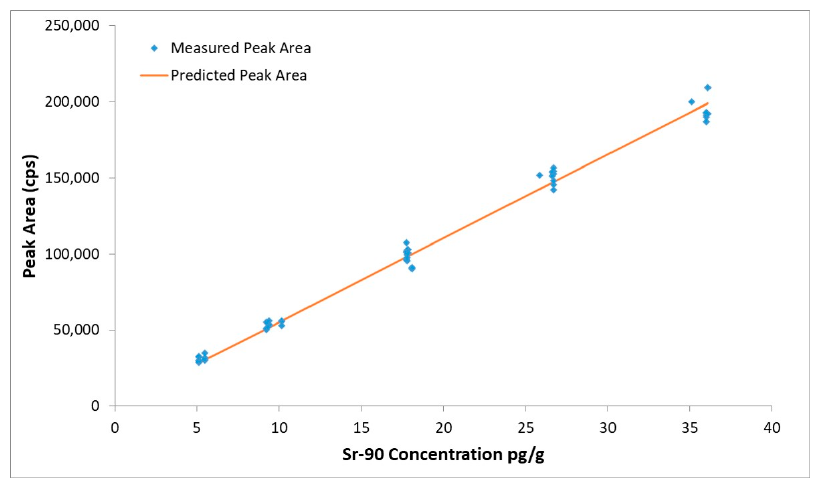
Figure 2. Liner regression for 90 Sr. The interval of concentration is from 5 to 40 pg g − 1 . Blue diamonds are the data points included to calculate the linear regression. The line represents predicted values.